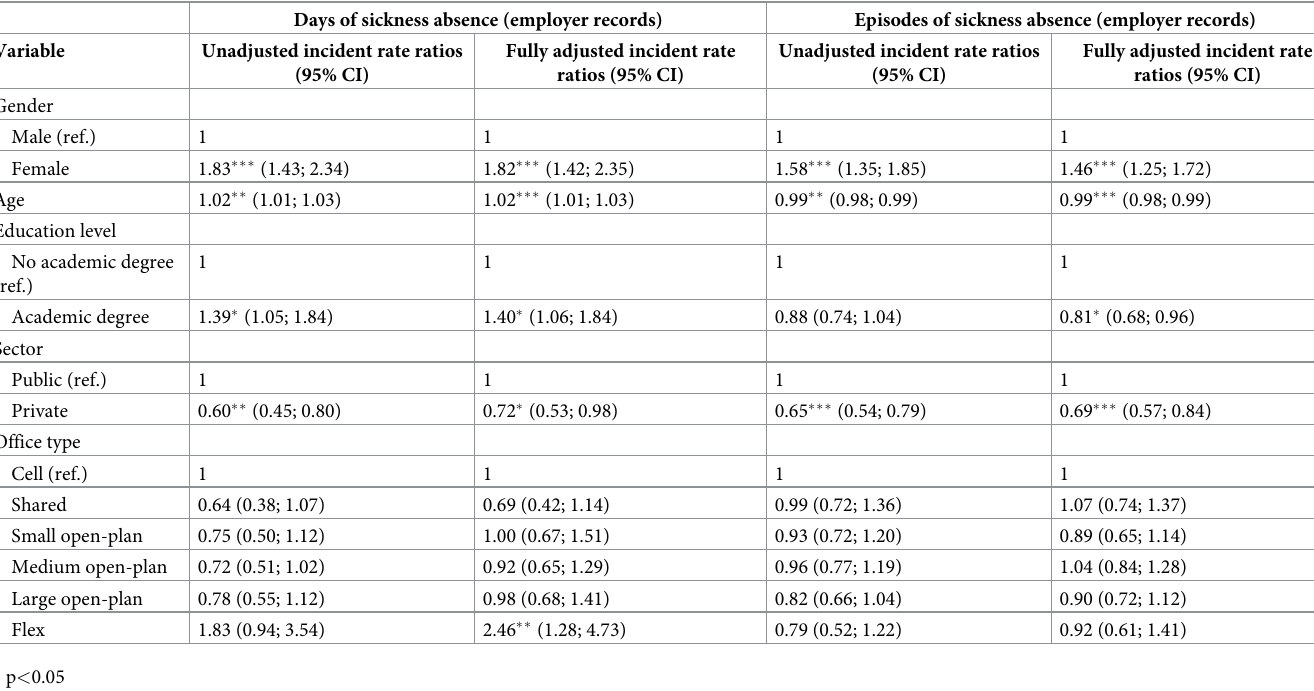
Table 6. Associations of office type with employer records of sickness absence: Results from negative binomial regressions (n =